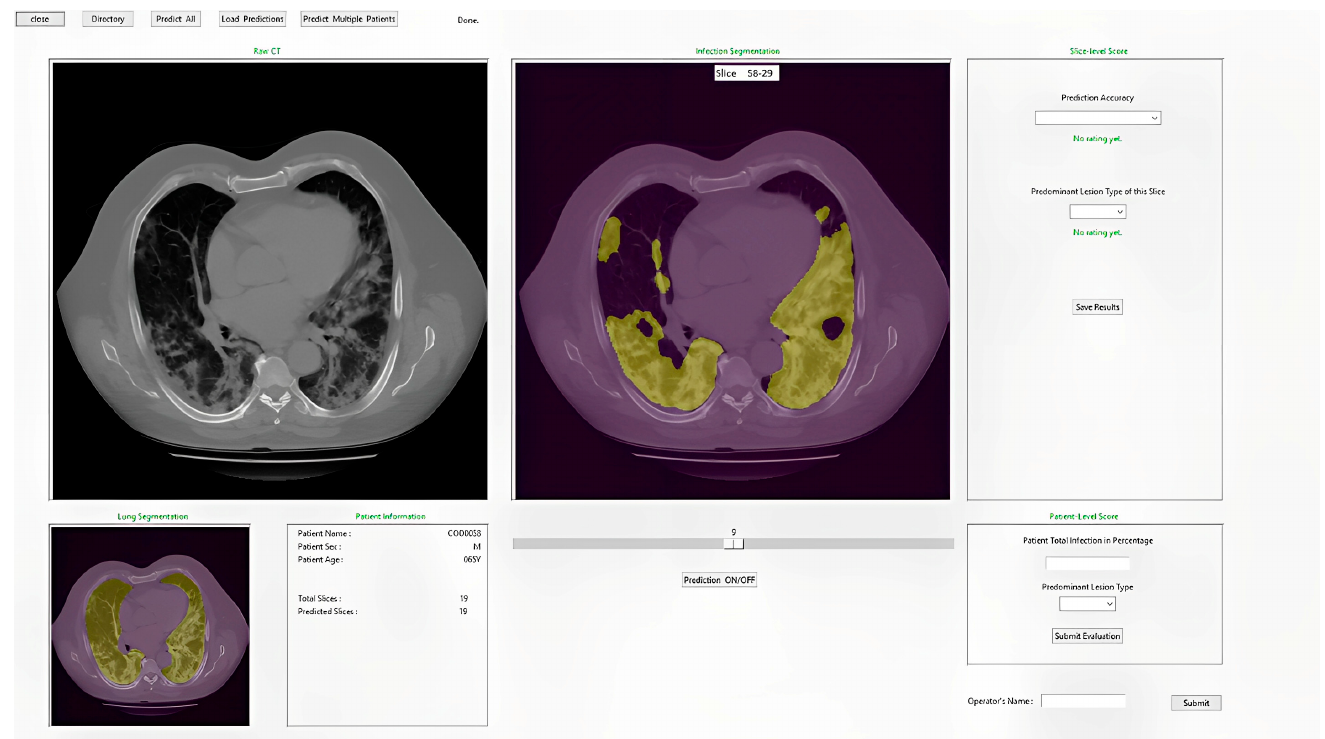
Figure 9. Illustration of the developed GUI for lung and COVID-19 infection segmentation.